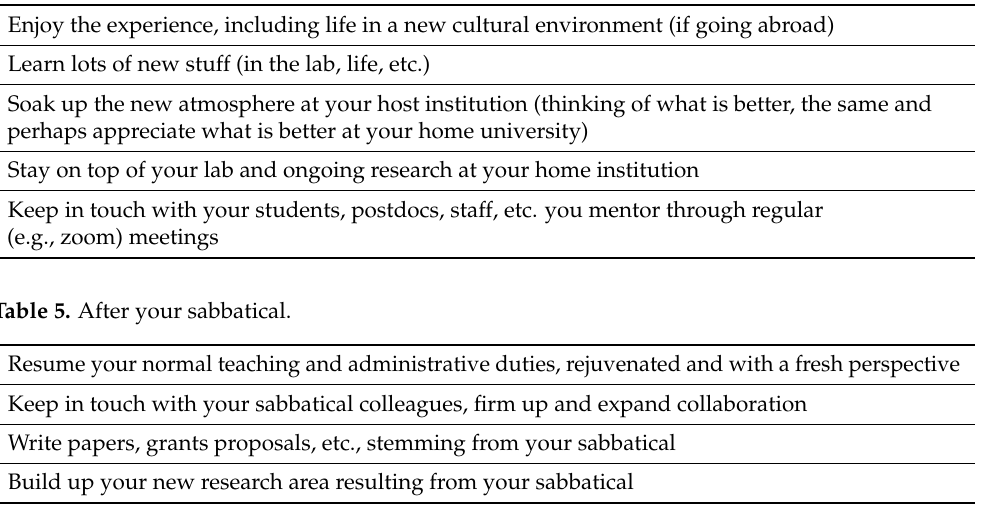
Table 4. During your sabbatical.